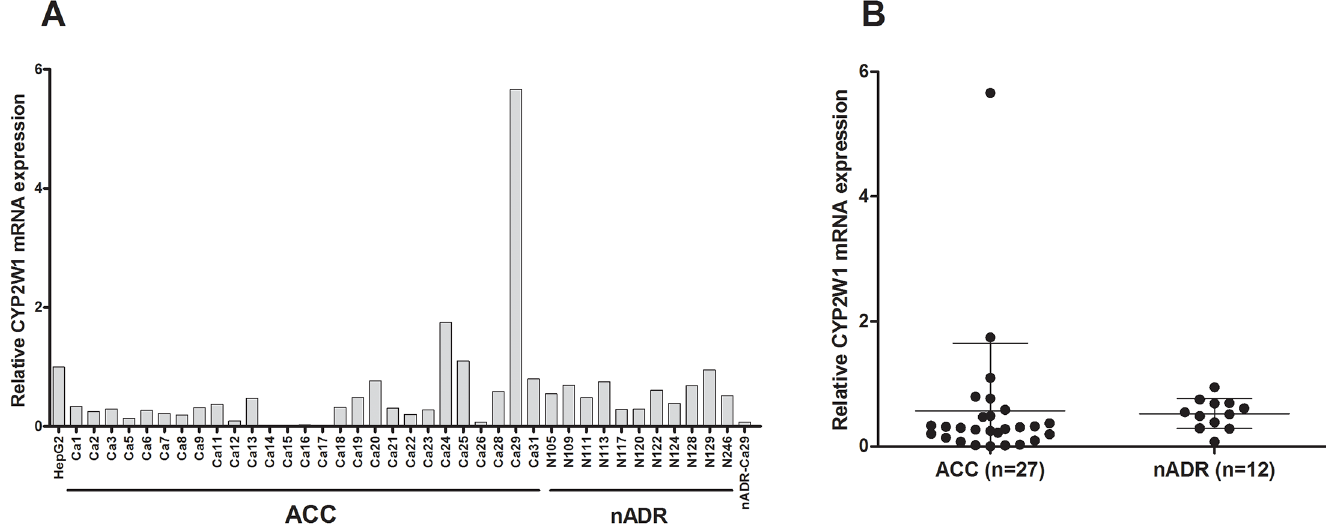
Fig 1. CYP2W1 mRNA expression in adrenocortical carcinoma and normal adrenal cortex tissue. A. CYP2W1 mRNA expression in adrenocortical carcinoma (Ca) and normal adrenal cortex tissue (N) compared to the expression in HepG2 cells. nADR-Ca 29 represents normal adrenal cortex from the patient Ca 29. B. The scatterplot shows mean ± SD of CYP2W1 mRNA expression in ACC and nADR samples, p = 0.89.